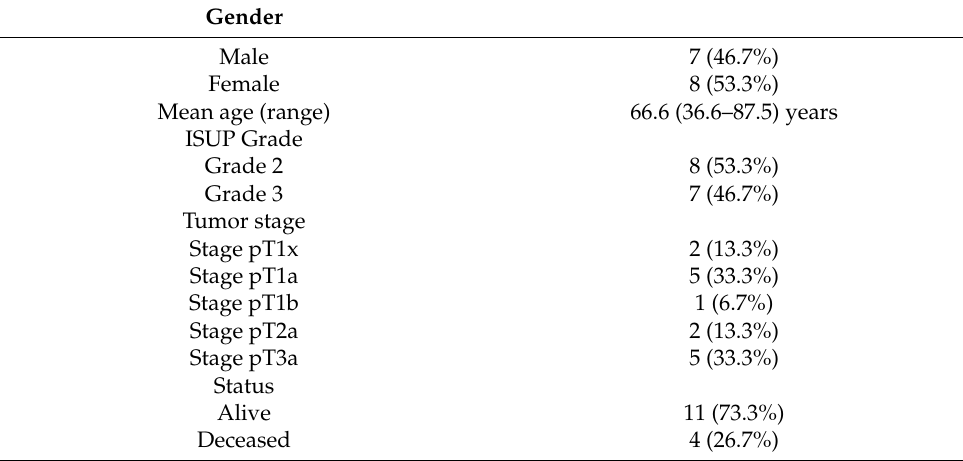
Table 1. Demographic details of the 15 patients with renal clear cell carcinoma.